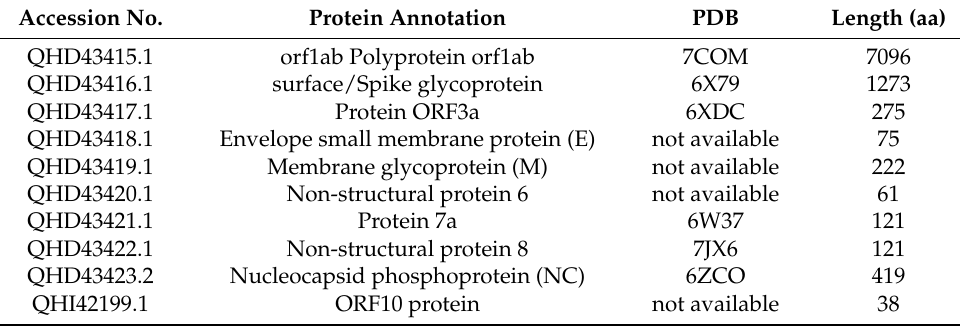
Table 3. SARS-CoV-2 proteins used in the immunogenic analysis. Accession No. Protein Annotation